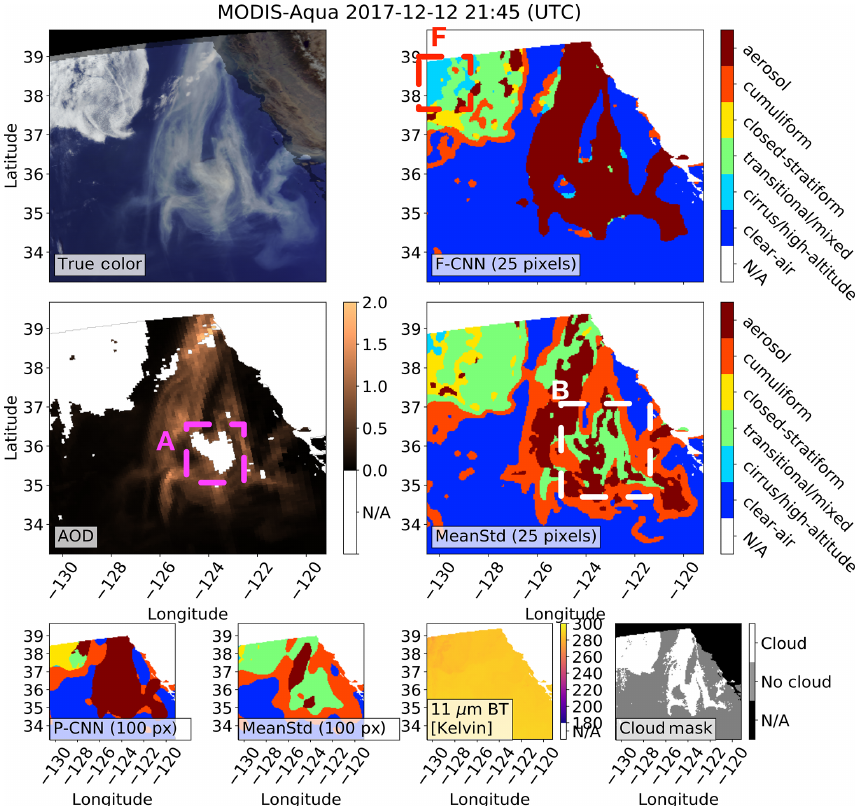
Figure 10. Box A shows where (1) the MODIS MYD04 aerosol product has bad aerosol optical depth (AOD) retrievals which are flagged as bad by the MYD04 quality control, (2) the MODIS MYD35 cloud-mask product labeled the aerosols as clouds, and (3) the pretrained 100-pixel CNN and fine-tuned 25-pixel CNN (F-CNN) methods were able to successfully detect the extreme aerosols. Box B shows where the baseline mean–standard deviation (MeanStd) methods misclassified the aerosols as clouds. Box F shows where a part of the clouds were misclassified as cirrus/high-altitude by the F-CNN method, which is possibly due to cirrus/high-altitude-labeled observations in the training dataset that have some contamination of other cloud classes. For all images any sun glint and landmasses have been masked